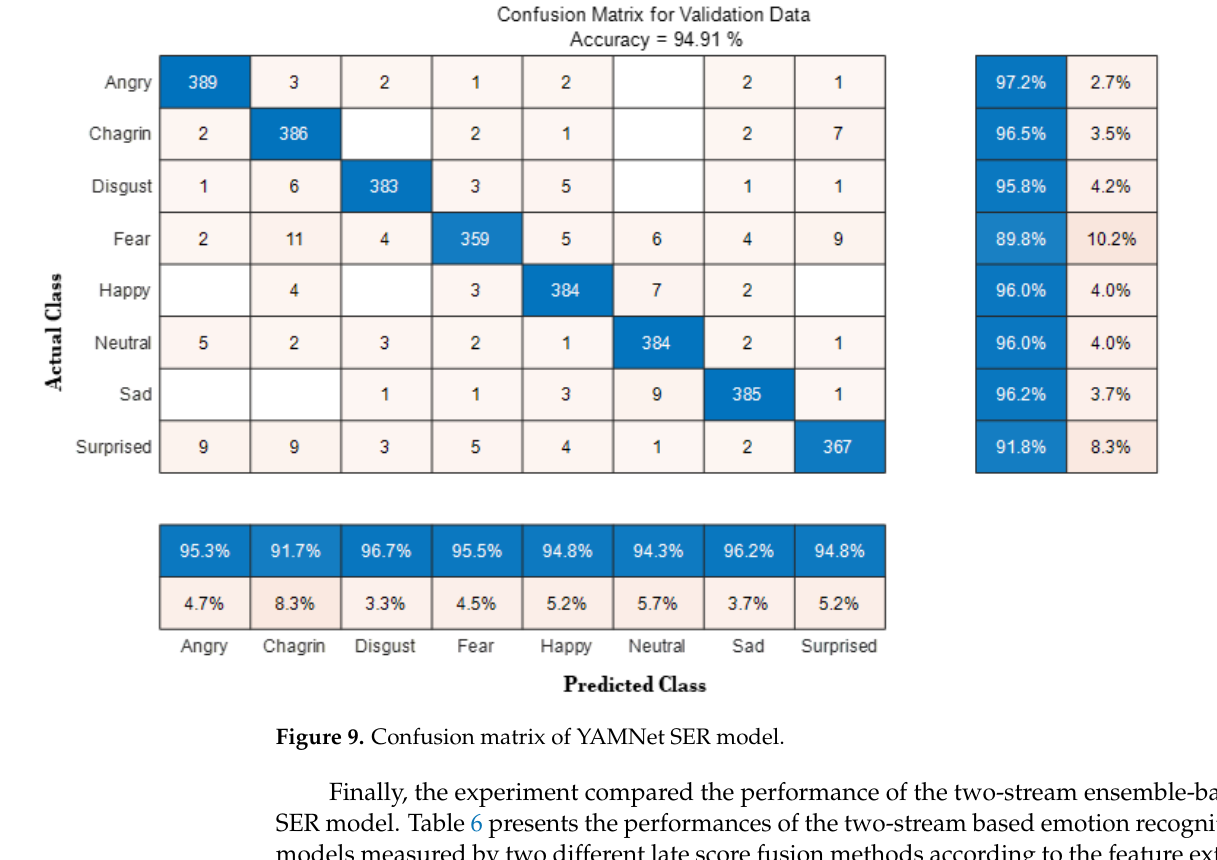
Table 6. Accuracy of two-stream-based SER